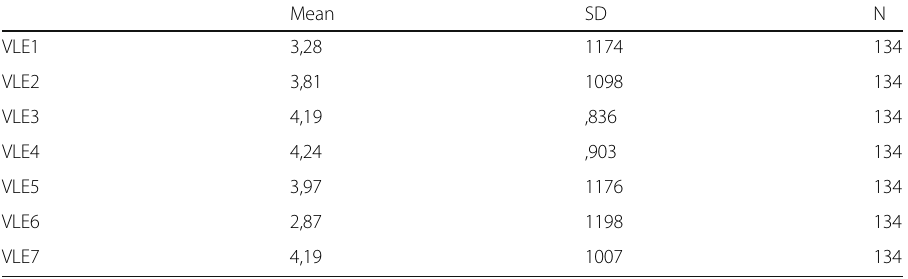
Table 7 Statistics of items on